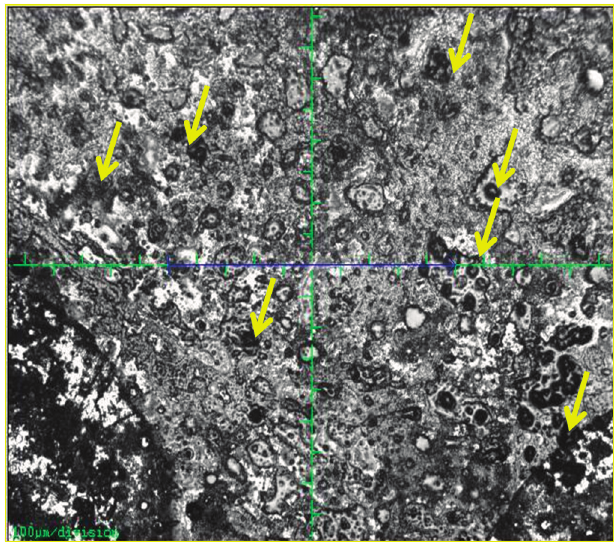
Figure 10. Alpha particle tracks as indicated by the yellow arrows can be clearly observed on the DNA film